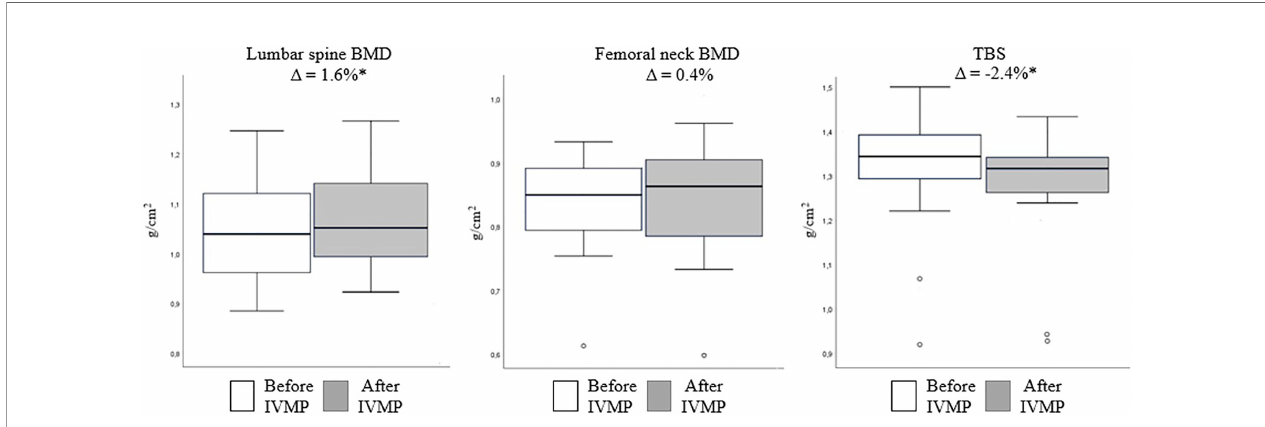
FIGURE 2 | Mean bone mineral density and trabecular bone score values before (white) and after (gray) intravenous methylprednisolone (IVMP) therapy. Values shown above are D , calculated as 100 x (after IVMP value – before IVMP value)/before IVMP value. Data are expressed as mean ± SD. *p<0.05 vs. baseline. BMD, bone mineral density; TBS, trabecular bone score; IVMP, intravenous methylprednisolone therapy; SD, standard